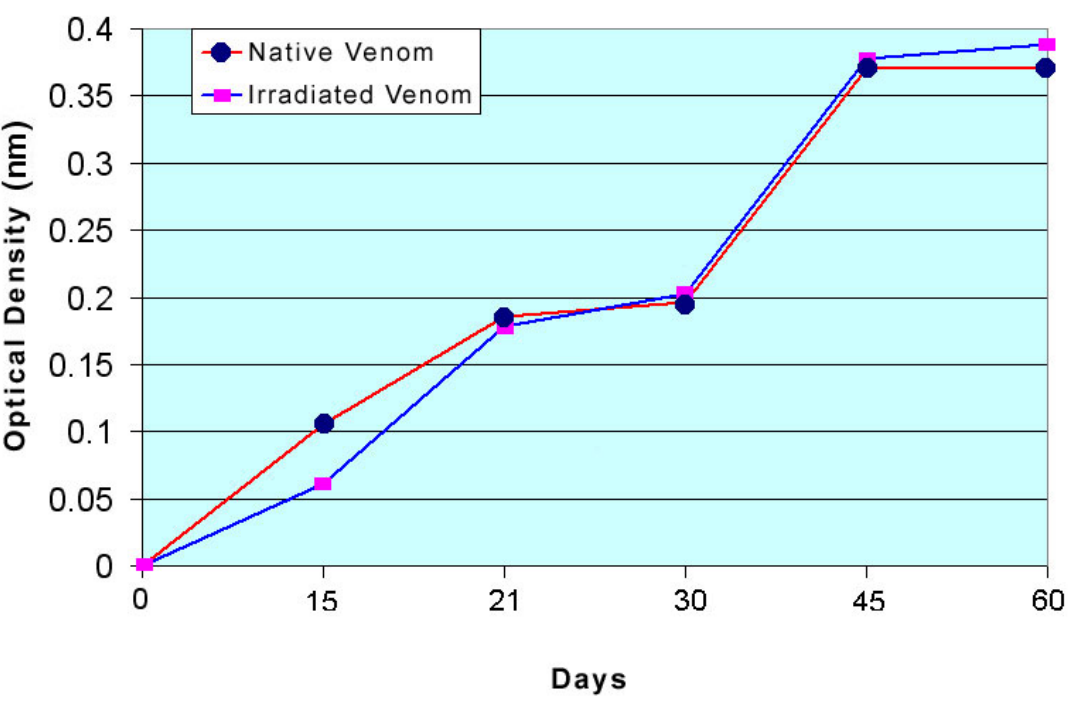
Figure 3: Distribution of the optical densities mean values in different moments, using serum from animals inoculated with Bothrops moojeni venom, native (GV) and 60 Co- irradiated (GVI), diluted in 1:200. G V x G VI; F = 1.49 < F = 7.71 ( α = 5 Lines critical